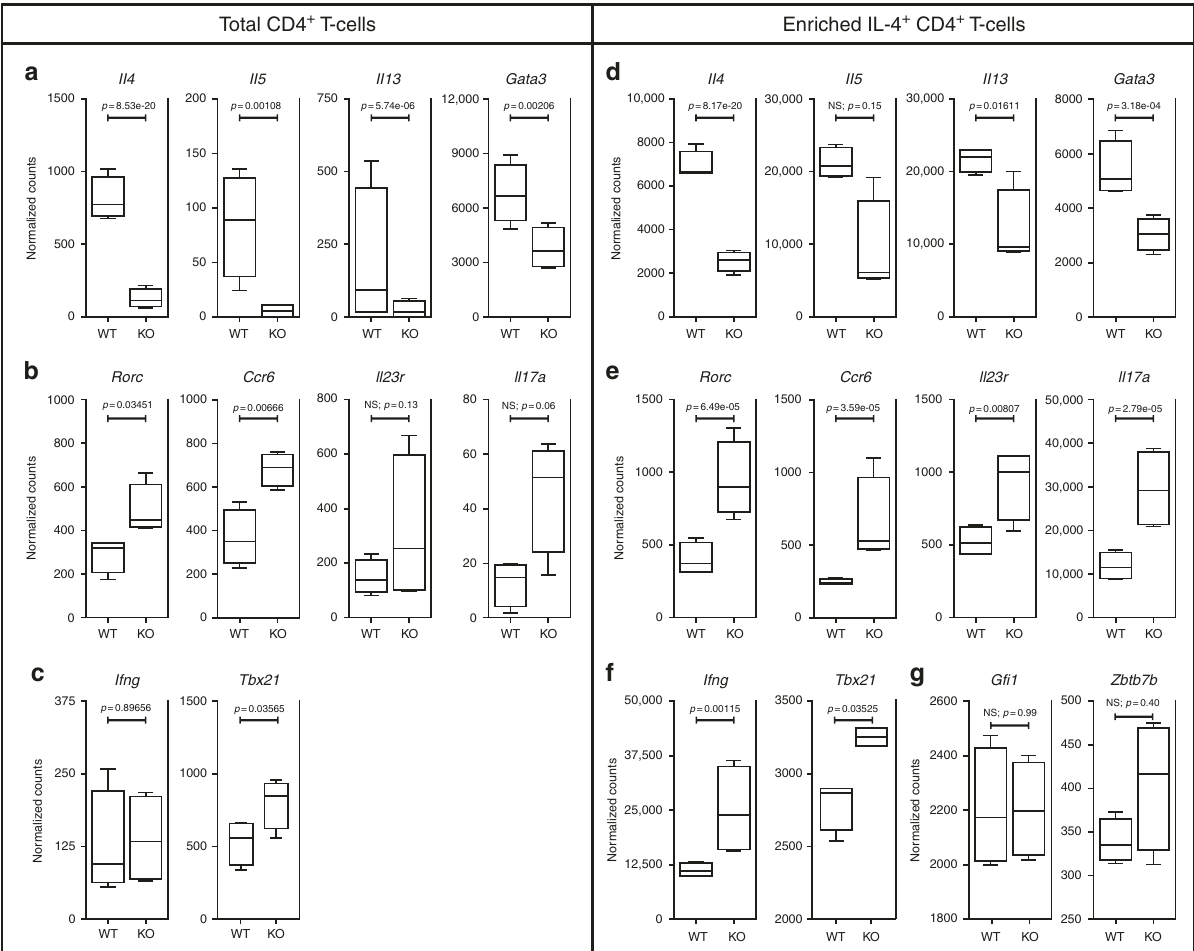
Fig. 3 Bcl11b-de fi cient CD4 + T-cells downregulate the Th2 program and upregulate Th17 and Th1 genes. a – c Box and whisker plots of normalized counts for speci fi c Th2-associated ( a ), Th17-associated ( b ), and Th1-associated ( c ) mRNAs derived from RNA-Seq on total CD4 + T-cells from the mLNs of H. polygyrus bakeri infected Bcl11b fl / fl dLck-iCre mice ( n = 4) and Bcl11b fl / fl control mice ( n = 4). Normalized counts and statistical analyses were taken from DESeq2 analysis software. Data are derived from two independent experiments. p values have been adjusted for the FDR (false discovery rate) by the Benjamini – Hochberg adjustment. d – f Box and whisker plots of normalized counts for speci fi c Th2-associated ( d ), Th17-associated ( e ), and Th1-associated ( f ) mRNAs derived from RNA-Seq on IL-4 + -enriched CD4 + T-cells from the lung parenchyma of asthma-induced Bcl11b fl / fl dLck-iCre mice ( n = 4) and Bcl11b fl / fl control mice ( n = 4). g Box and whisker plots of normalized counts for G fi 1 and Zbtb7b mRNA from RNA-Seq on IL-4 + -enriched CD4 + T-cells from the lung parenchyma of asthma-induced Bcl11b fl / fl dLck-iCre mice ( n = 4) and Bcl11b fl / fl control mice ( n = 4). Normalized counts and statistical analyses were taken from DESeq2 analysis software. p values have been adjusted for the FDR (false discovery rate) by the Benjamini – Hochberg adjustment. All error bars shown are of standard